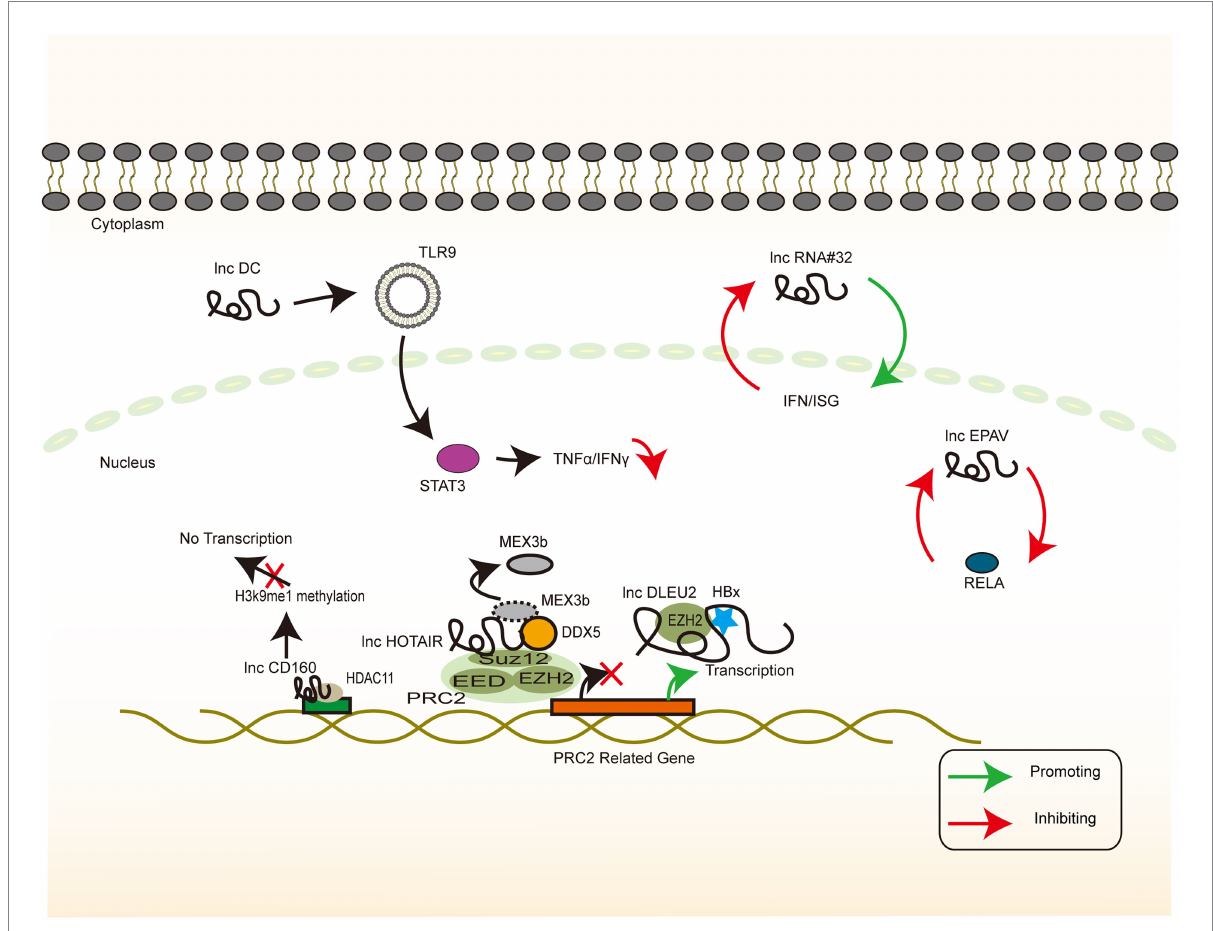
FIGURE 5 HBV-related lncRNAs targeting the host genome (Part I). The signaling pathway of IFN-associated lncRNA whose target of action is located in the host genome. Colour blocks indicate different molecules, irregular lines indicate lncRNA, and large double-stranded lines indicate host genomic DNA. Green arrows indicate the upregulation, while red arrows indicate the